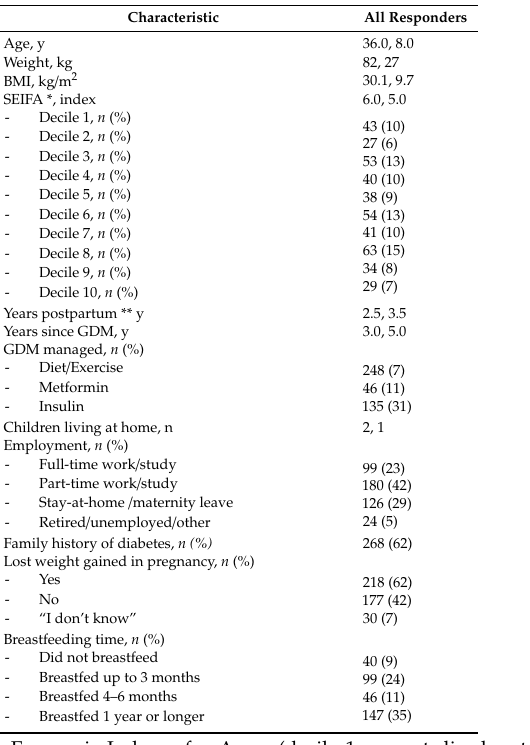
Table 1. Characteristics of survey